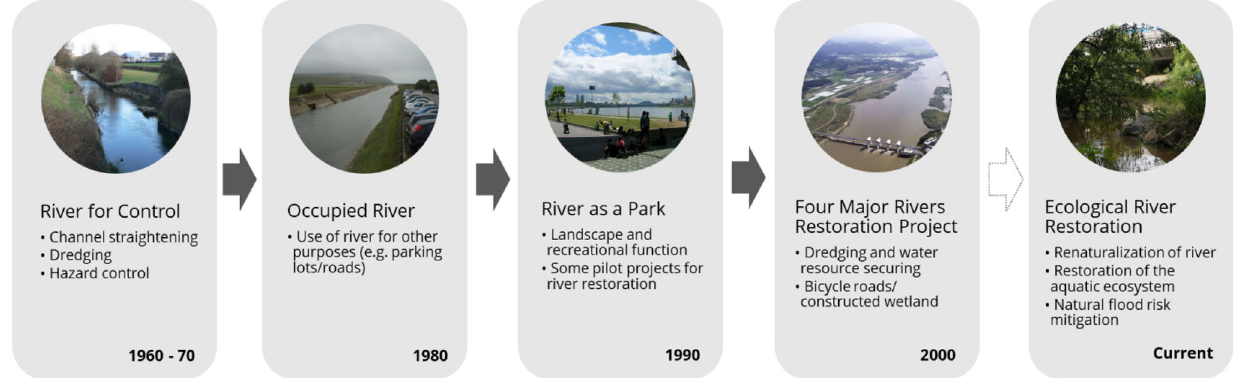
Fig. 1 Changes in river management in South Korea. Source Wikimedia